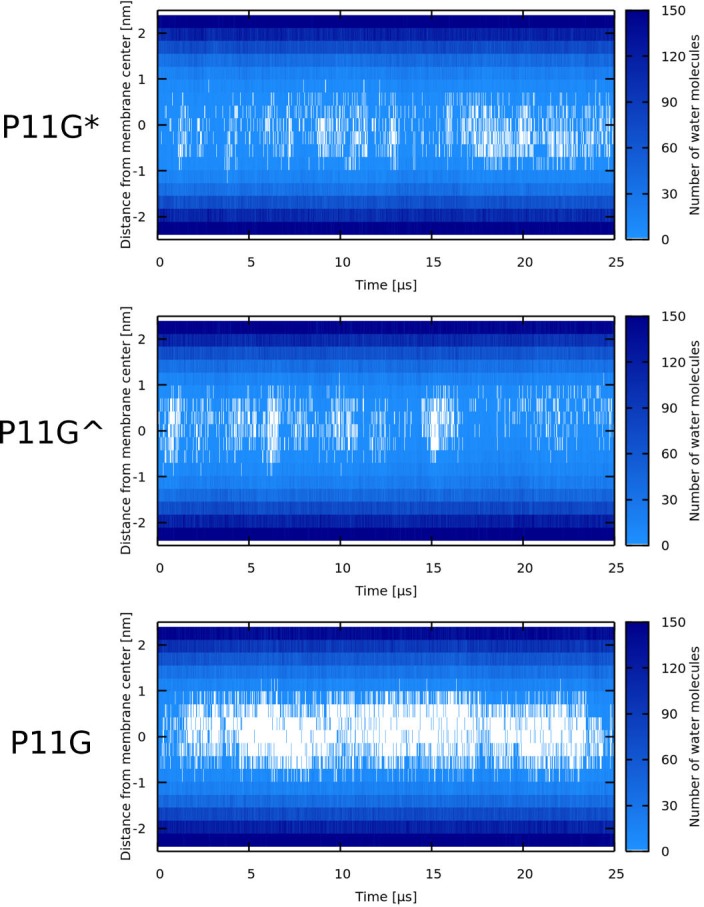
Water density profiles for Buforin II P11G in POPC membrane.P11G* denotes a sequence that was forced to be α-helical. In case of Buforin II P11G^, only the glycine residue formed the flexible kink.